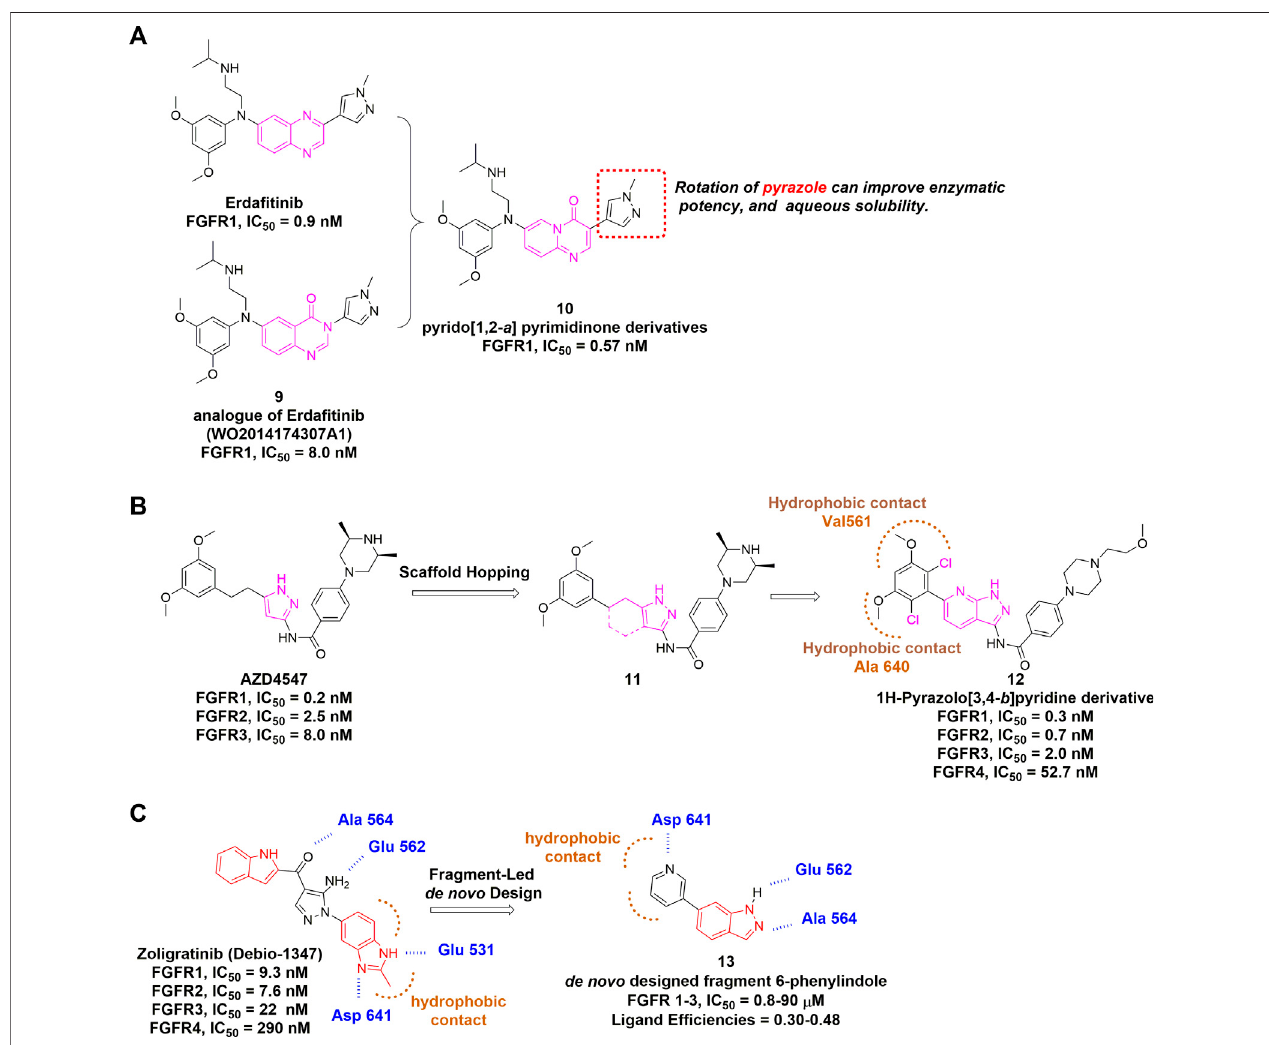
FIGURE 9 | (A) Discovery of pyrido [1,2- a ] pyrimidinone derivatives as non-covalent pan-FGFR inhibitor. (B) Discovery of 1H-Pyrazolo [3,4- b ]pyridine derivatives from AZD4547 and summary of its interactions with FGFR1 ATP binding site. Hydrophobic interactions are outlined by hashed brown arc (PDB: 4V05). (C) Summary of CH5183284 and designed